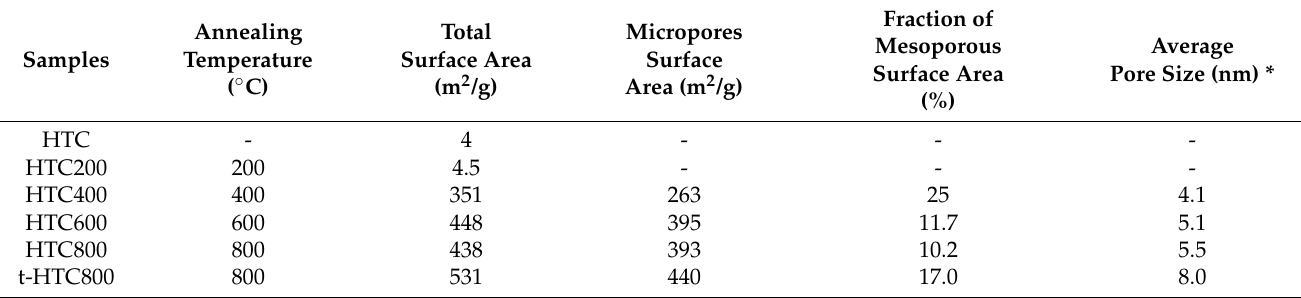
Table 1. Textural properties of HTC materials as a function of the annealing